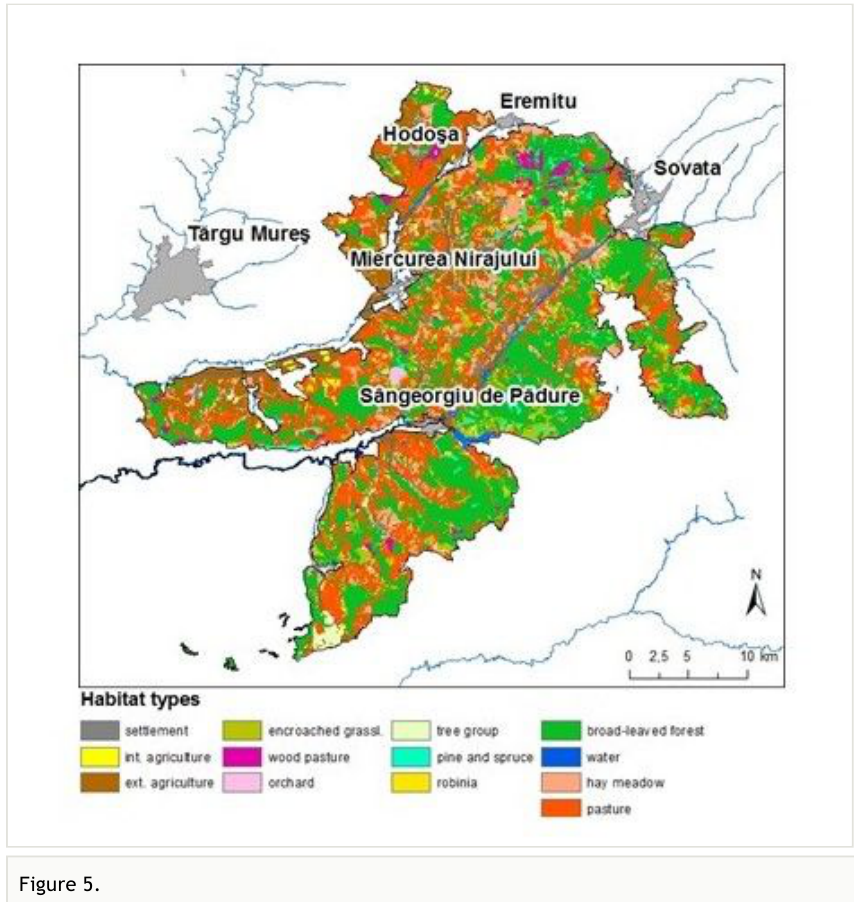
The fi nal ecosystem map consisting of 13 ecosystem / habitat type